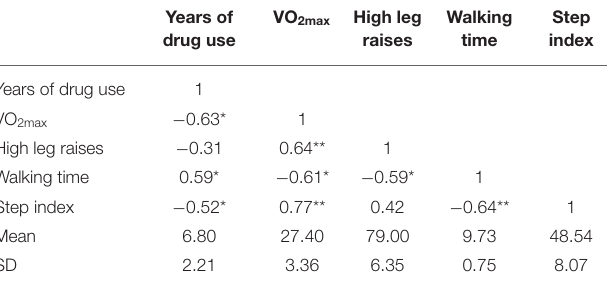
TABLE 4 | Correlation matrix of natural plant-derived drug addicts ( n = 30).